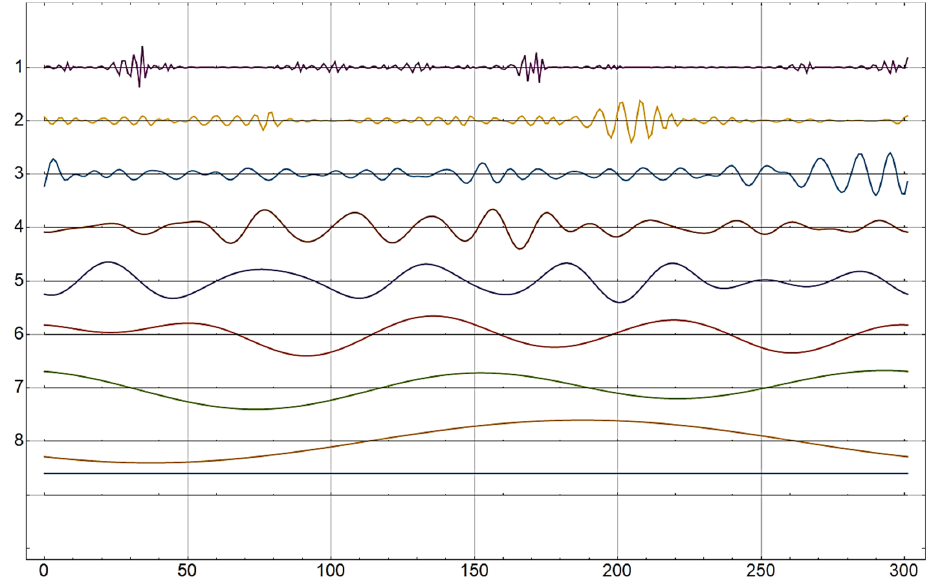
Figure 4. Decomposition of the original time series, compiled from the values of the daily cash balances in the 2019 federal budget TSA into eight levels (the dynamics of each component of the decomposed signal) after DWT. Source: authors’ calculations.